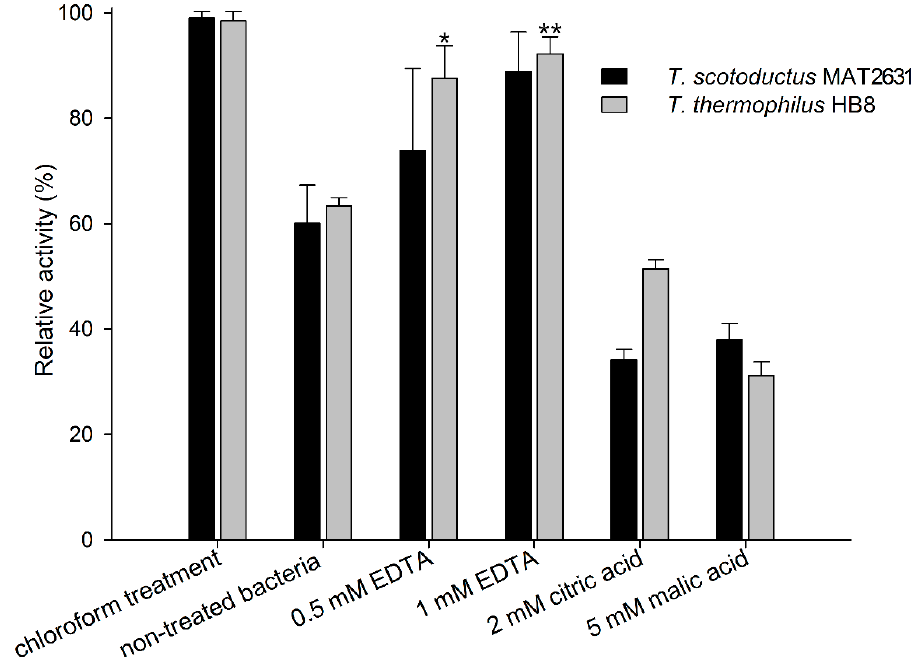
Figure 1. Comparison of the lytic activity of Ts2631 endolysin against chloroform-treated vs. planktonic bacterial substrates in the presence or absence of outer membrane permeabilizers. The activity of Ts2631 endolysin was analysed at 60 ° C on planktonic T. scotoductus MAT2631 (black bars) and T. thermophilus HB8 (grey bars) in the absence (non-treated bacteria) or in the presence of the following outer membrane permeabilizers (OMPs): 0.5 mM EDTA, 1 mM EDTA, 2 mM citric acid, and 5 mM malic acid. The activity of Ts2631 endolysin is indicated as a percentage relative to the activity against chloroform-treated bacterial substrates (chloroform treatment). Negative controls (reaction mixtures with substrate bacteria with or without OMPs) were subtracted from the sample